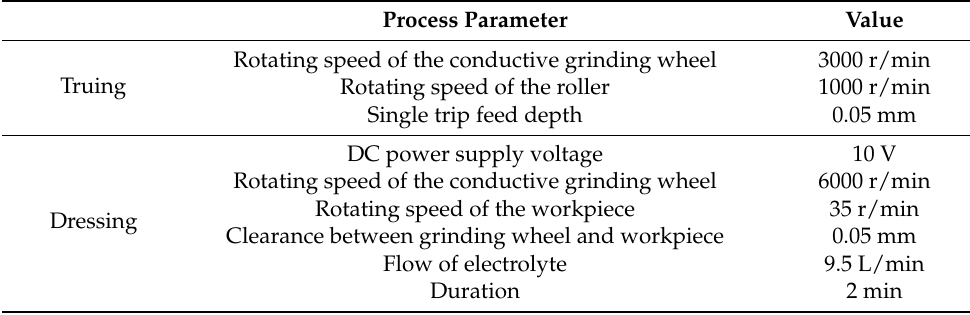
Table 2. The process parameters of conductive grinding wheel truing and